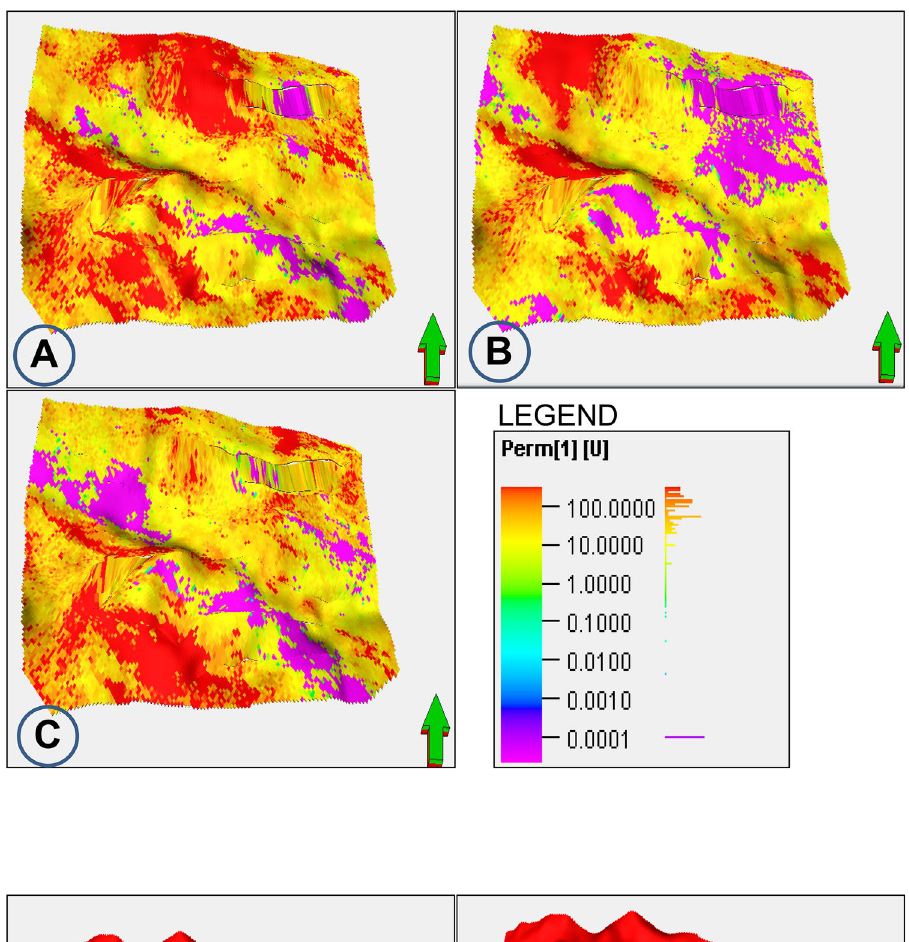
Fig. 12 Equiprobable realiza- tions of permeability from K200 reservoir